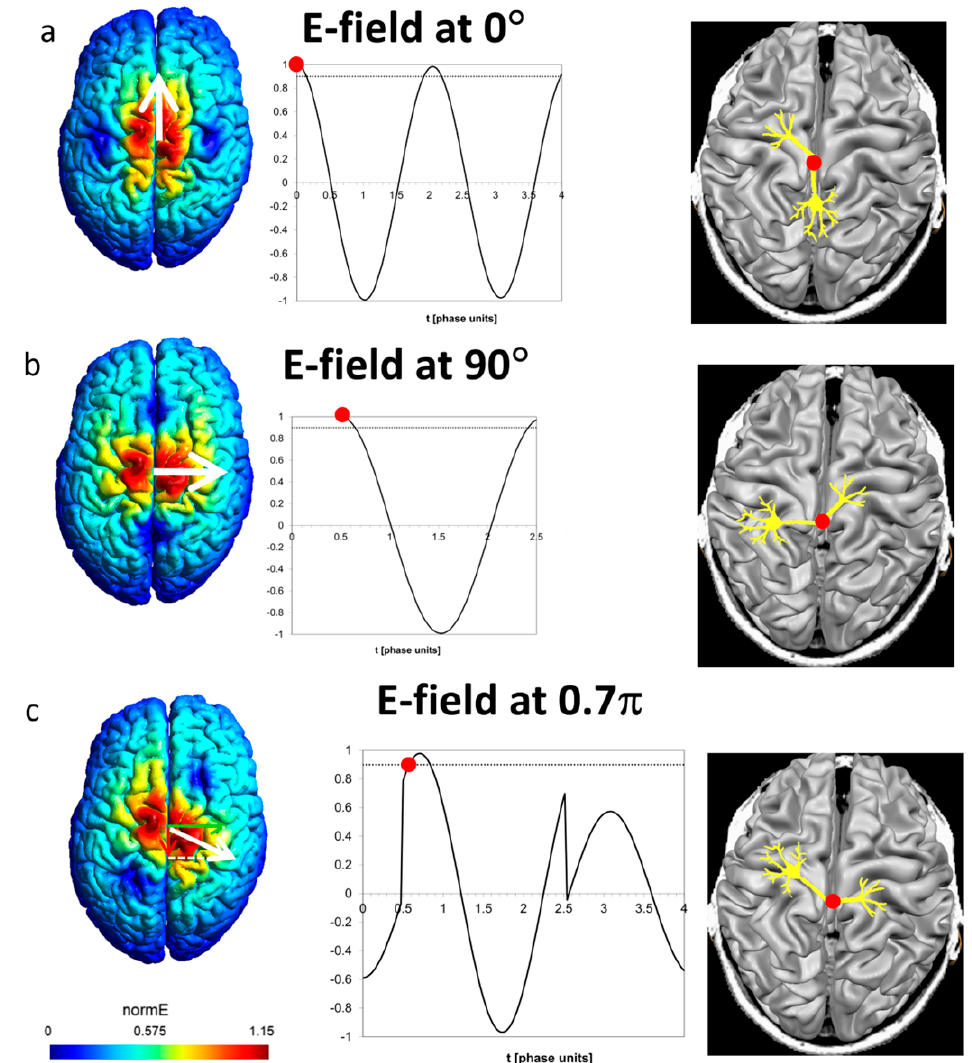
Figure 5. ( a ). Preferred posterior–anterior direction (angle 0 ◦ ). Only the lower coil contributes to the field along this axis. Stimulation occurs at t = 0. ( b ). Preferred left-right direction (angle 90 ◦ = 0.5 π ). Only the upper coil contributes to the field along this axis. Stimulation occurs at t = 0.5 π once the lower coil is operated. ( c ). Preferred direction at angle 0.7 π . Both coils contribute to the field along this axis. Stimulation occurs at about t = 0.6 π once the field reaches the threshold (dashed line).